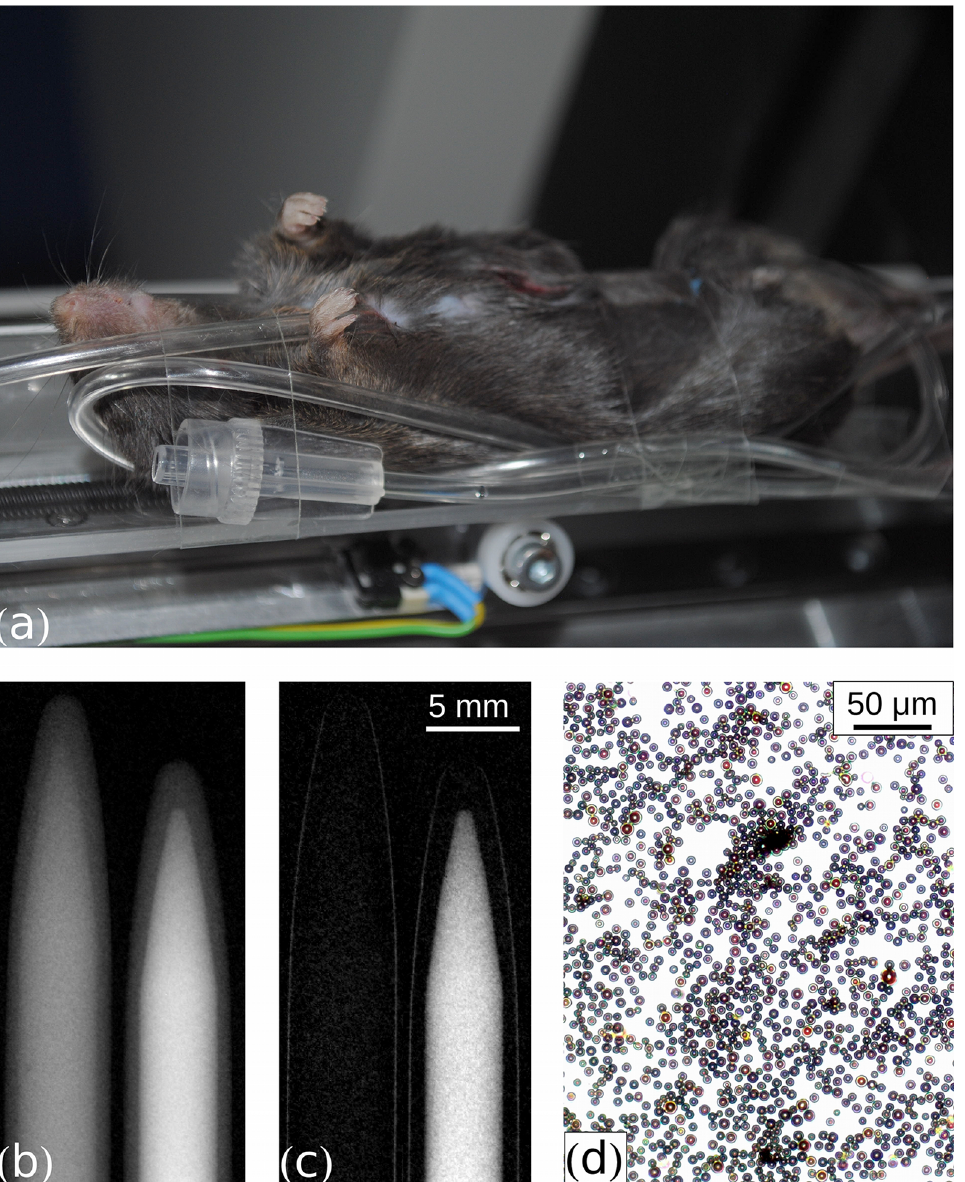
Fig 1. Sample positioning and preliminary imaging of PVA contrast agent. (a) Mouse carcass fixated on the animal bed of a preclinical phase-contrast and dark-field CT scanner. A plastic tube was surgically inserted underneath the peritoneum and some spare volume of the tube for flushing the contrast agent downwards was attached to the right side of the mouse. (b) Transmission image of plastic vials containing water (left) and PVA microbubbles (right). Grey values ranging from 0 to 0.35. (c) Dark-field image of plastic vials containing water (left) and PVA microbubbles (right). Grey values ranging from 0 to 0.75. (d) Visible-light brightfield microscopy image of PVA microbubbles.